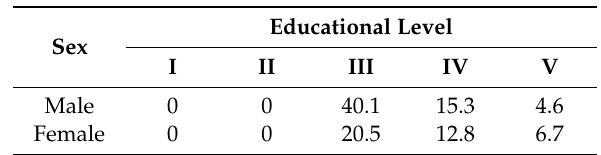
Table 7. Sample distribution (% of total) by sex and educational level classified as: I: primary education; II: lower secondary education; III: upper secondary education; IV: bachelor/master; V: doctorate or equivalent.